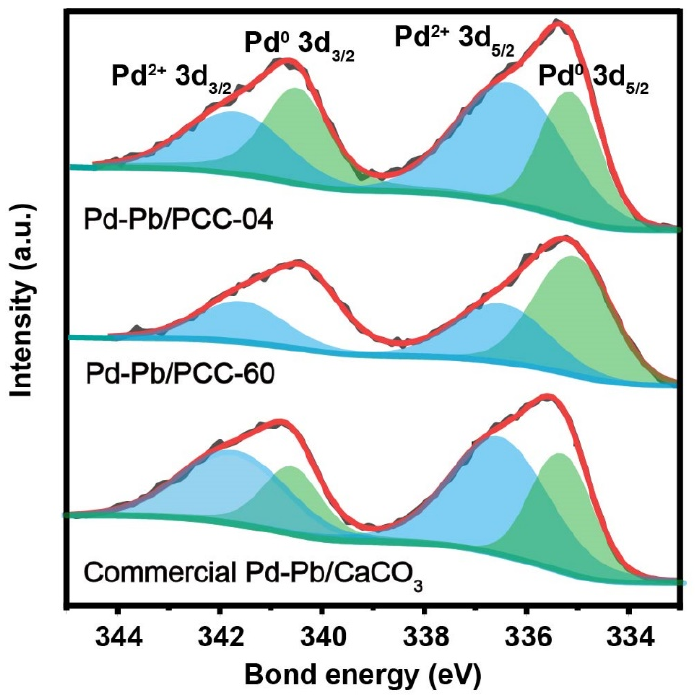
Figure 4. X-ray photoelectron spectroscopy (XPS) profile of Pd 3d on 5 wt% Pd-Pb/ PCC-04, 5 wt% Pd-Pb/PCC-60, and commercial 5 wt% Pd-Pb/CaCO 3 . We refer to Figures S13–S15 for additional characterization data.